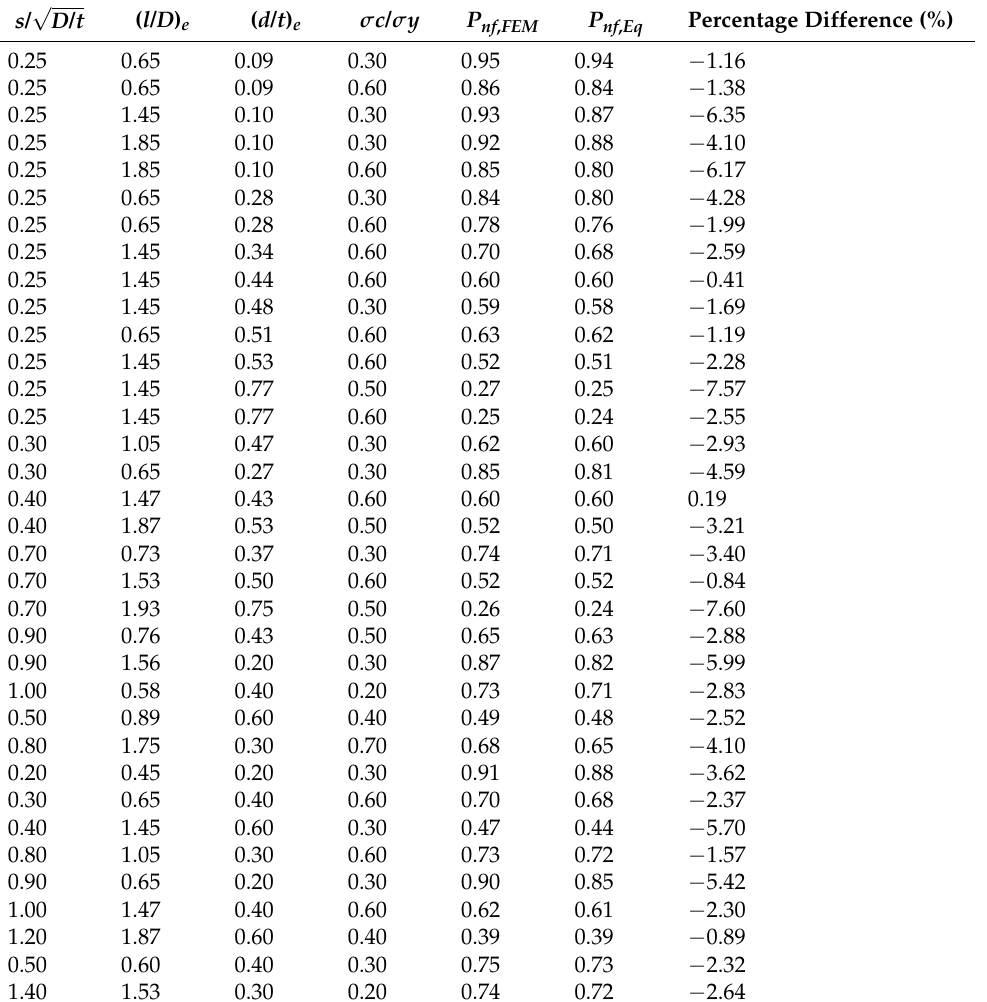
Table 13. Comparison of the failure pressure obtained using FEM and the empirical